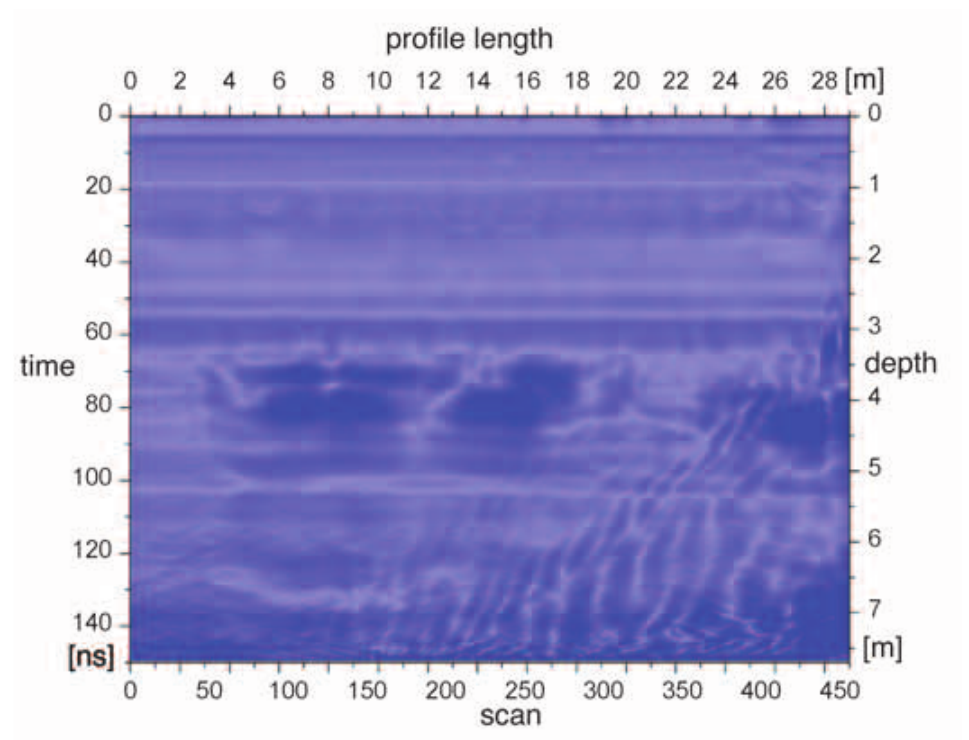
Fig. 7. Ground Penetrating Radar profile (along magnetic anomaly D, fig. 4a). Data were acquired in continuous mode using a trace acquisition rate of 40 scan/s. Right side axis indicates the signal penetrating